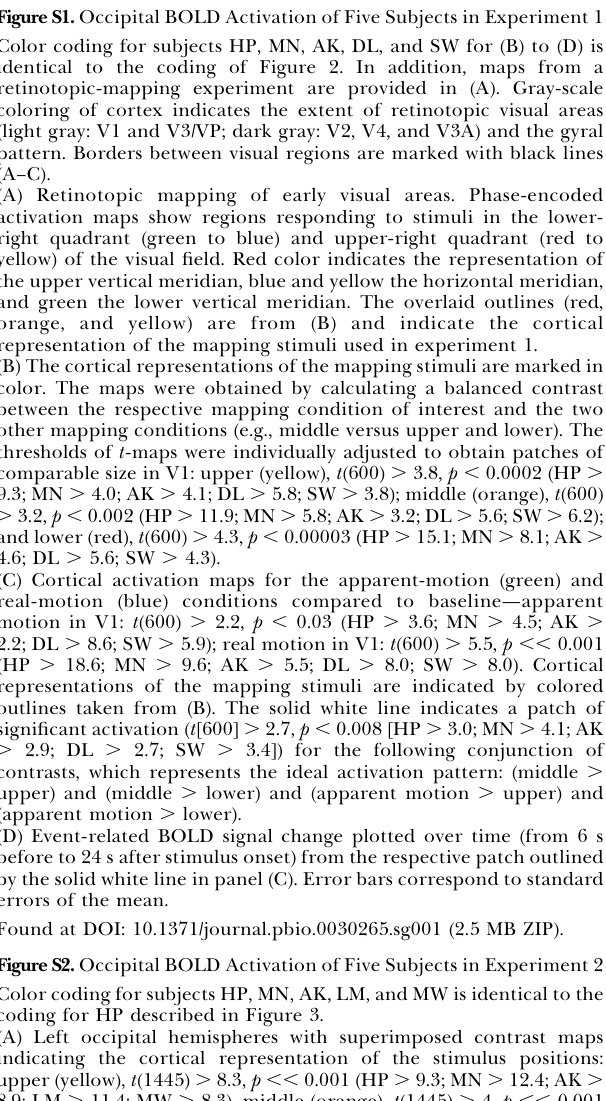
FigureS2. Occipital BOLD Activation of Five Subjects in Experiment 2 Color coding for subjects HP, MN, AK, LM, and MW is identical to the coding for HP described in Figure 3. (A) Left occipital hemispheres with superimposed contrast maps indicating the cortical representation of the stimulus positions: upper (yellow), t (1445) . 8.3, p ,, 0.001 (HP . 9.3; MN . 12.4; AK . 8.9; LM . 11.4; MW . 8.3), middle (orange), t (1445) . 4, p ,, 0.001 (HP . 11.9; MN . 10.4; AK . 4.0; LM . 11.4; MW . 5.9), and lower (red), t (1445) . 4.2, p ,, 0.001 (HP . 15.1; MN . 11.0; AK . 11.0; LM . 6.3; MW . 4.2). For comparison, the patches from experiment 1 are marked with dotted lines. (B) Cortical activation maps for apparent motion (green) and real motion (blue). In this case, apparent motion is contrasted with the flicker control condition (apparent motion . flicker in V1: t [1445] . 2.1, p , 0.05 [HP . 3.6; MN . 2.4; AK . 3.4; LM . 3.0; MW . 2.6]); real motion is compared to fixation baseline (real motion . baseline in V1: t [1445] . 10.1, p ,, 0.001 [HP . 18.6; MN . 20.3; AK . 10.1; LM . 12.6; MW . 11.1]). The white line in (B) indicates the